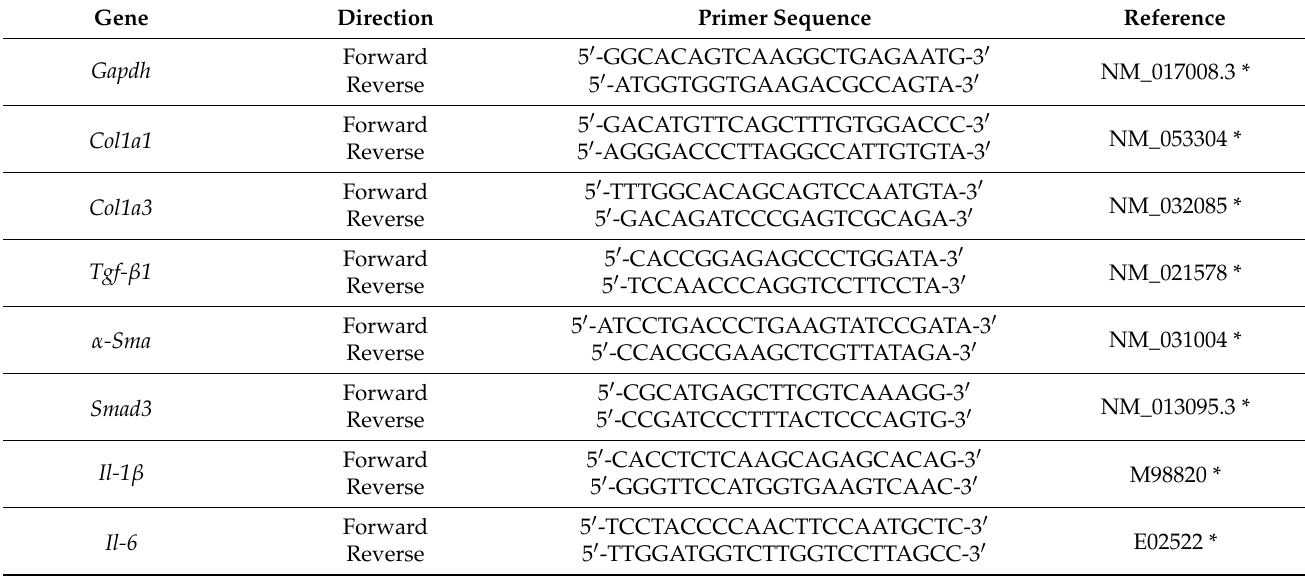
Table 1. Rat primer sequences used for RT-qPCR